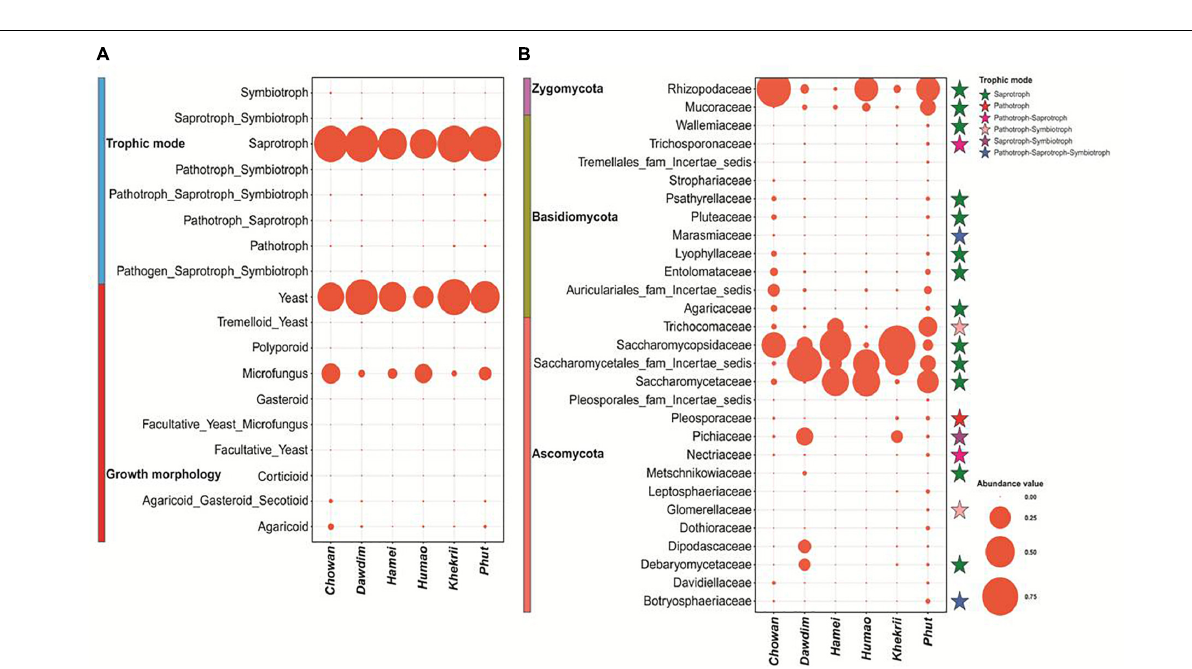
FIGURE 4 | (A) Bubble plot describing the features of mycobiome with relative abundance distribution present in starters. (B) Bubble plot describing the relative abundance distribution of family level diversity and their trophic mode of nutrition found in dried starters. Family level diversity having > 1.0% abundance in each sample was taken for this